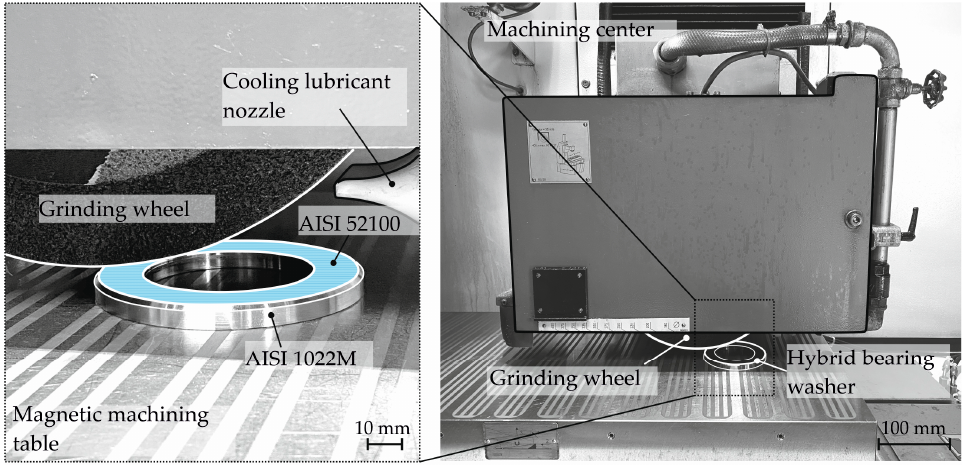
Figure 6. Machining setup in the CNC grinding machine.